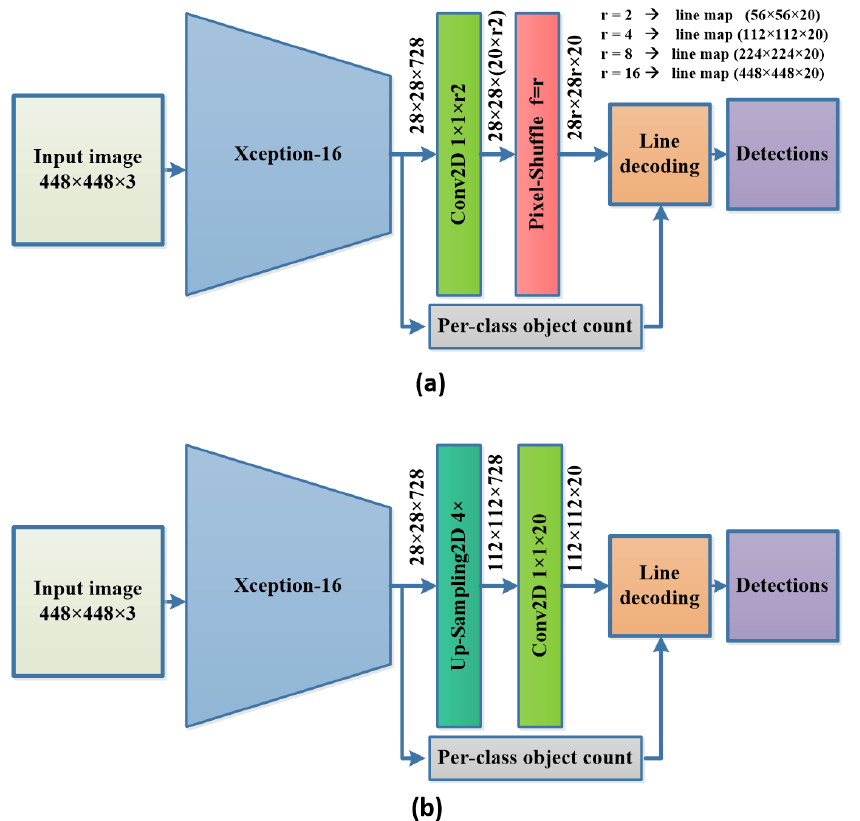
Figure 5. Ablation study architectures. ( a ) The architecure for the different scales of the line mask (1/8, 1/4, 1/2, 1/1 of the input image). ( b ) The architecure for the different upsampling techniques (bilinear, nearest neigbour, pixel-shuffle).